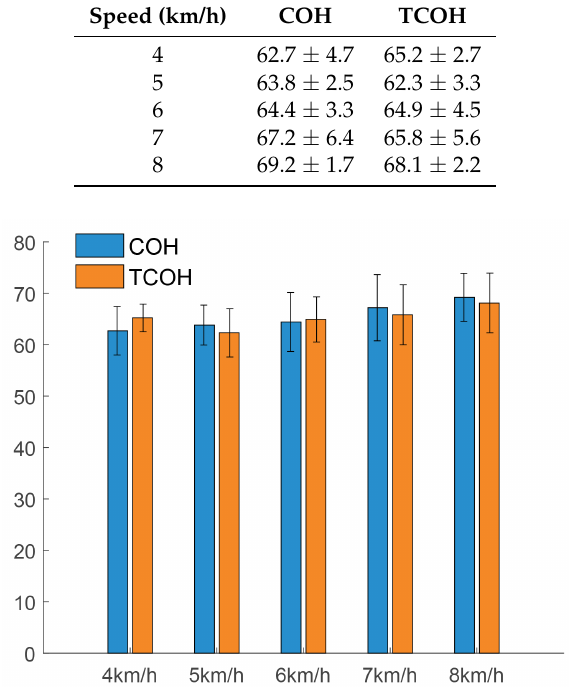
Figure 6. Bar graph of the COH and TCOH of EH device calculated by the metabolic work at speed of 4 km/h, 5 km/h, 6 km/h, 7 km/h, and 8